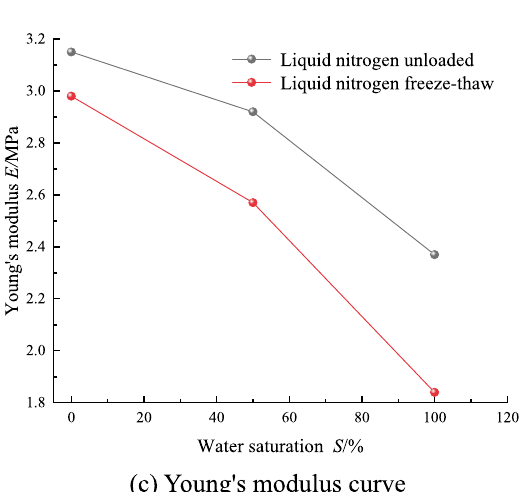
Figure 6. Test result curve of coal sample strength damage